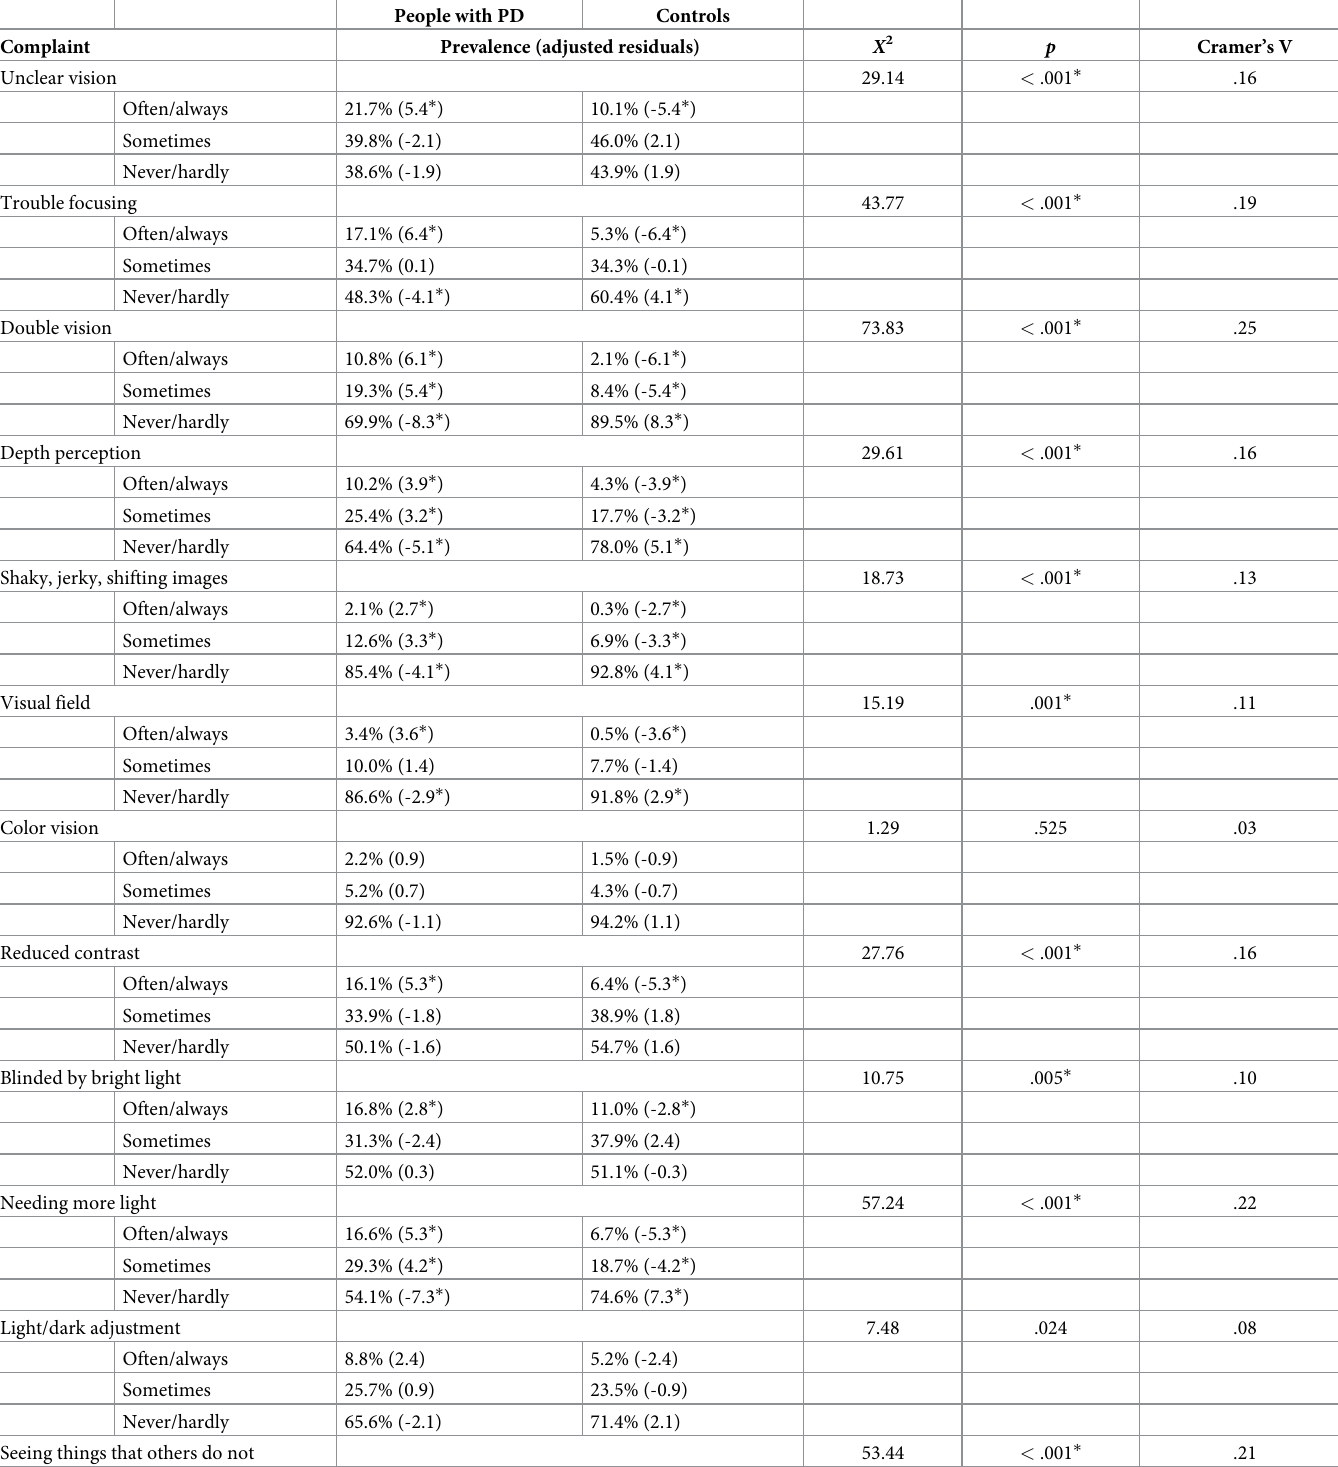
Table 2. Overview of the frequencies of people with PD and controls experiencing the SVCq’s visual complaints, and results of Chi-square tests comparing the groups. People with